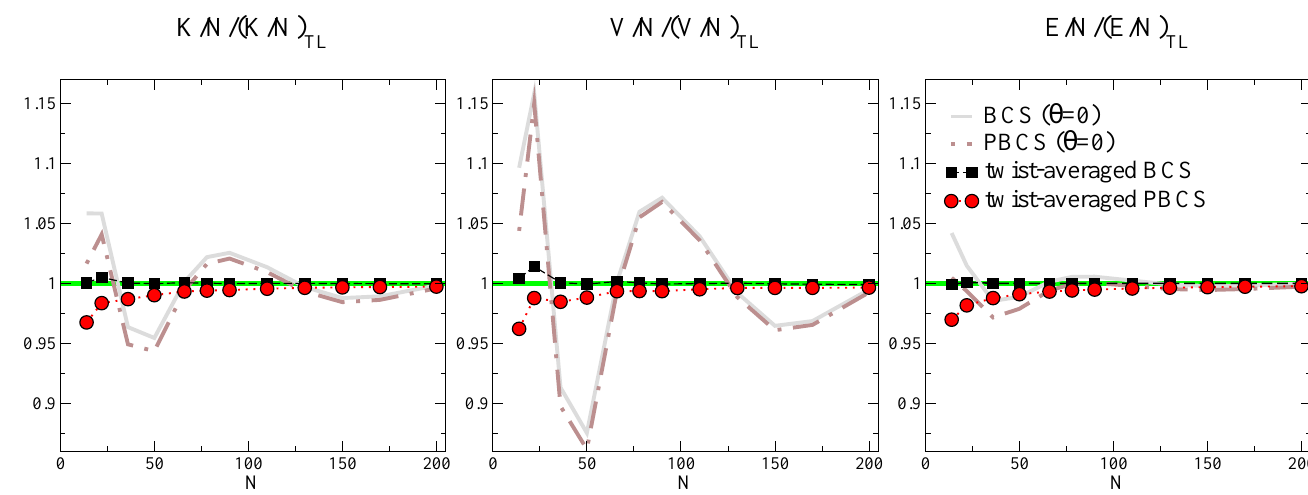
Figure 8. The BCS and PBCS energies under PBC and the twist-averaged boundary condition